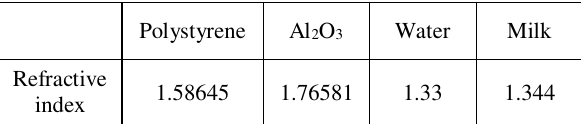
Table 1. Optical parameters used in the